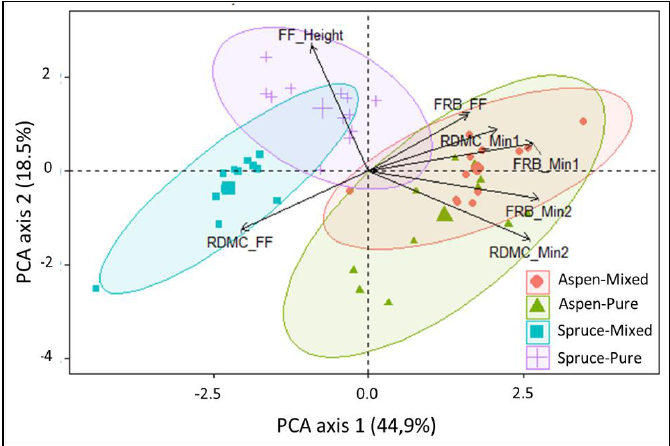
Figure 4. Principal component analysis of fine root biomass (FRB) and root dry matter content (RDMC) characterizing the rooting system of black spruce and trembling aspen in pure and mixed stands. The depth of organic horizon (FF_Height) was included in the analysis as a supplementary variable. FF, Min1, and Min2 refer to organic, mineral soil at 0–15 cm, and mineral soil at 15–30 cm, respectively.